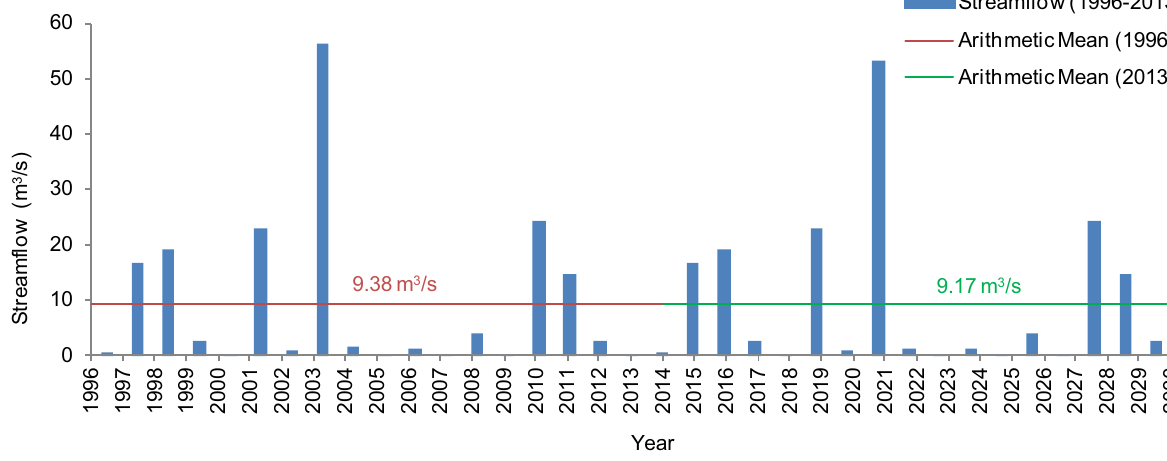
Fig. 15 Al Butum Wadi total simulated yearly streamflow (1996–2030)